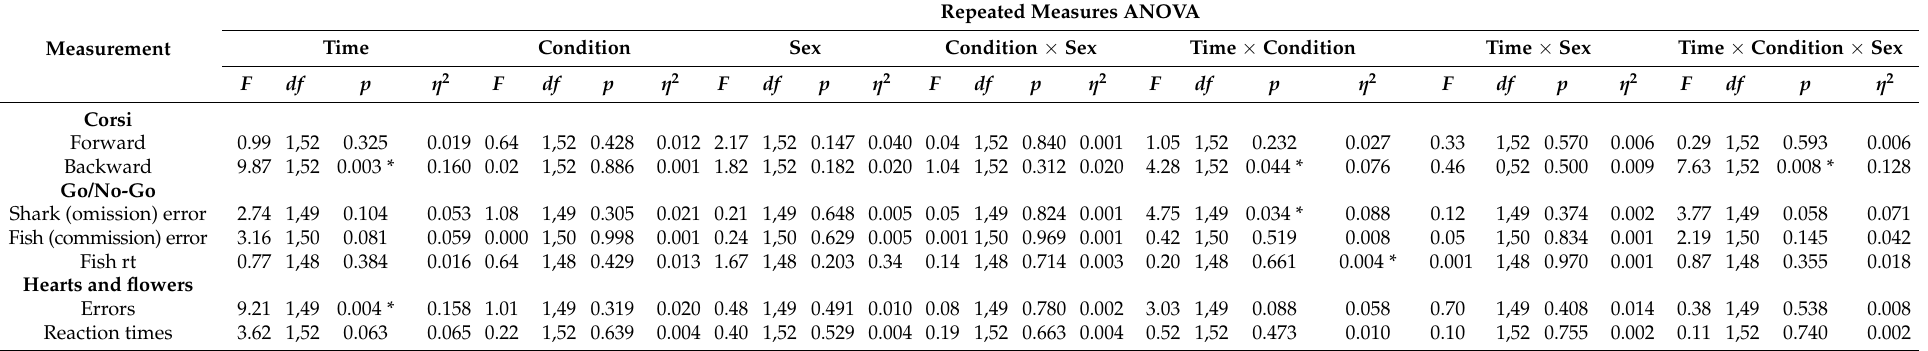
Table 2. Effects of the intervention on short-term memory, working memory and shifting